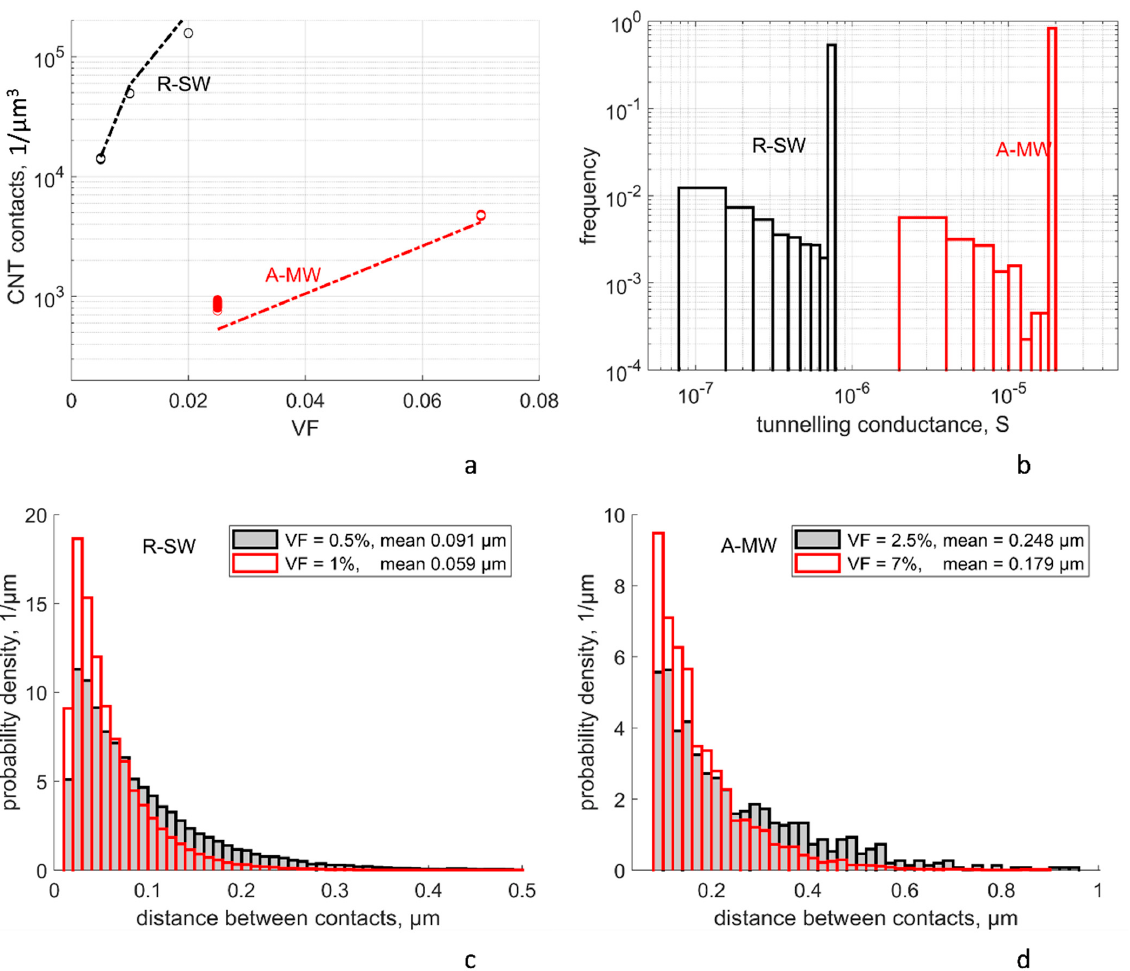
Figure 3. Characteristics of contacts for random RVEs: ( a ) density of CNT contacts, points: calculated values for random RVEs (the scatter is not noticeable for R-SW), lines: prediction according to Equation (8); ( b ) distribution of the tunneling conductances of CNT contacts, ∆ E 1 = 3 eV, s min = 0.34 nm, typical RVEs for R-SW (VF = 1%) and A-MW (VF = 7%) cases; ( c , d ) distribution of distances along CNTs between the contacts for R-SW ( c ) and A-MW ( d ) cases; mean values are shown in the